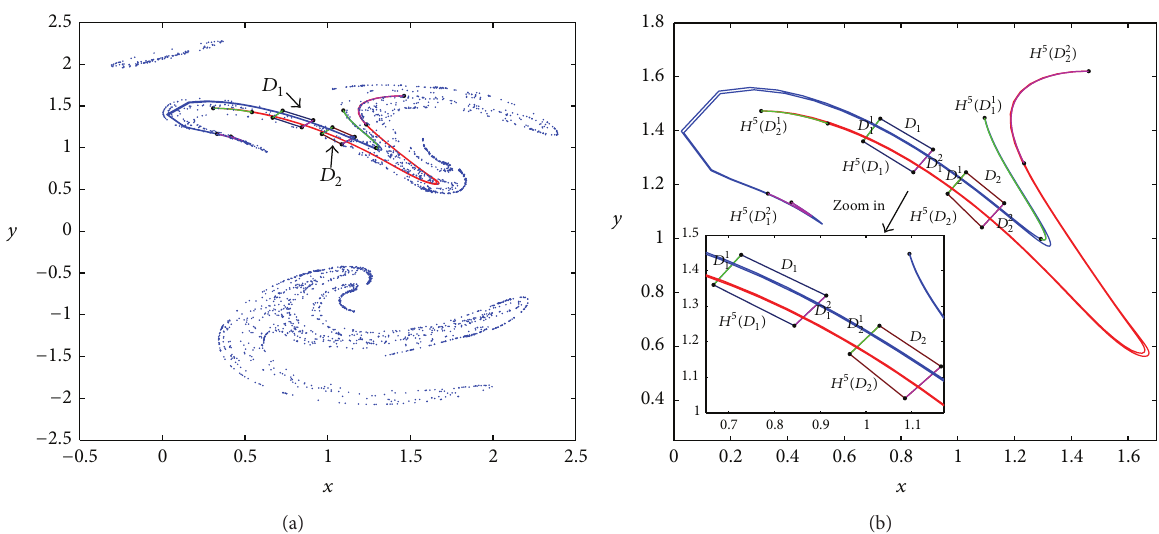
Figure 7: (a) Poincare mapping on the crossing 𝑧 = 0 . (b) The topological horseshoe at 𝐺 = 1